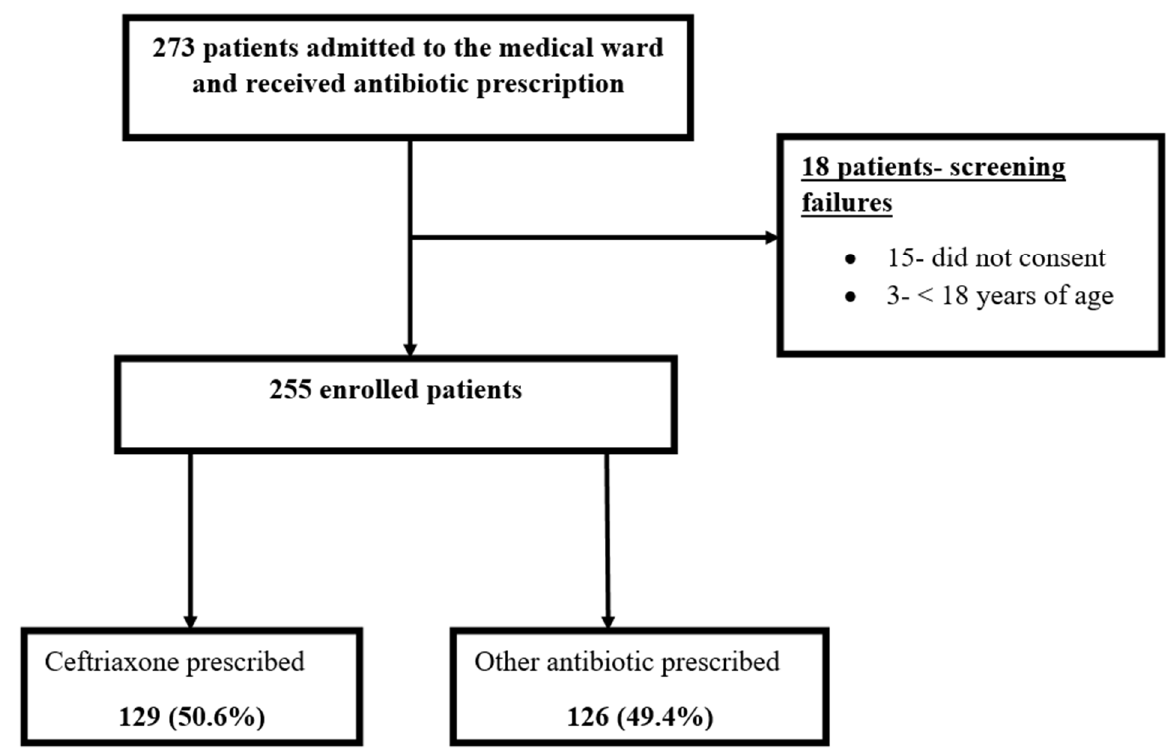
Figure 1. Study profile of hospitalized patients with antibiotic prescription.